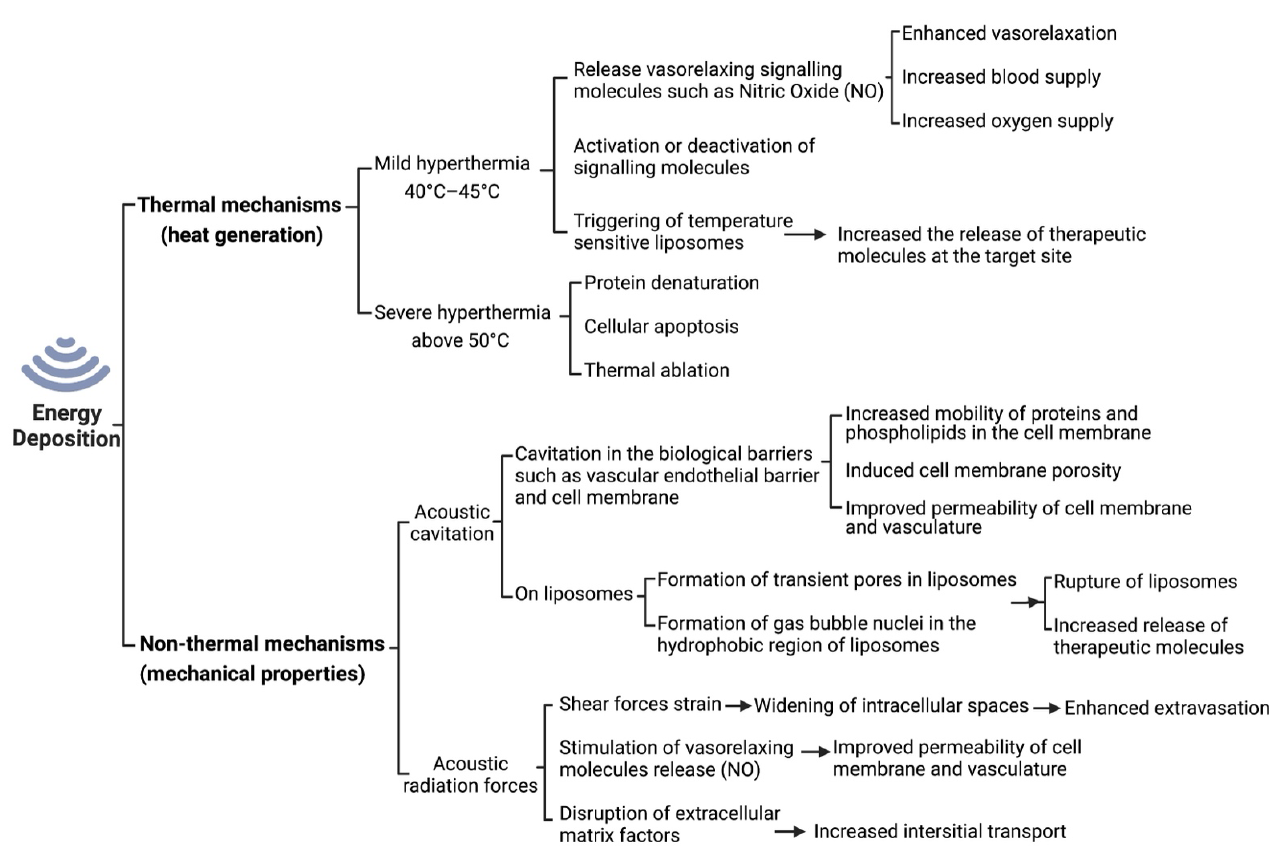
Figure 3. A schematic representation of the manner by which energy deposition from ultrasound exposures can act through various mechanisms. When ultrasound waves are applied to the targeted tissues, they produce mechanical, thermal, chemical and biological effects. The biological effects of ultrasound depend on the applied intensity, and depending on the dose and duration of admin- istration, ultrasound can produce reversible or irreversible effects [90]. Adapted with permission of Elsevier from ref [88]; permission conveyed through Copyright Clearance Center, Inc.